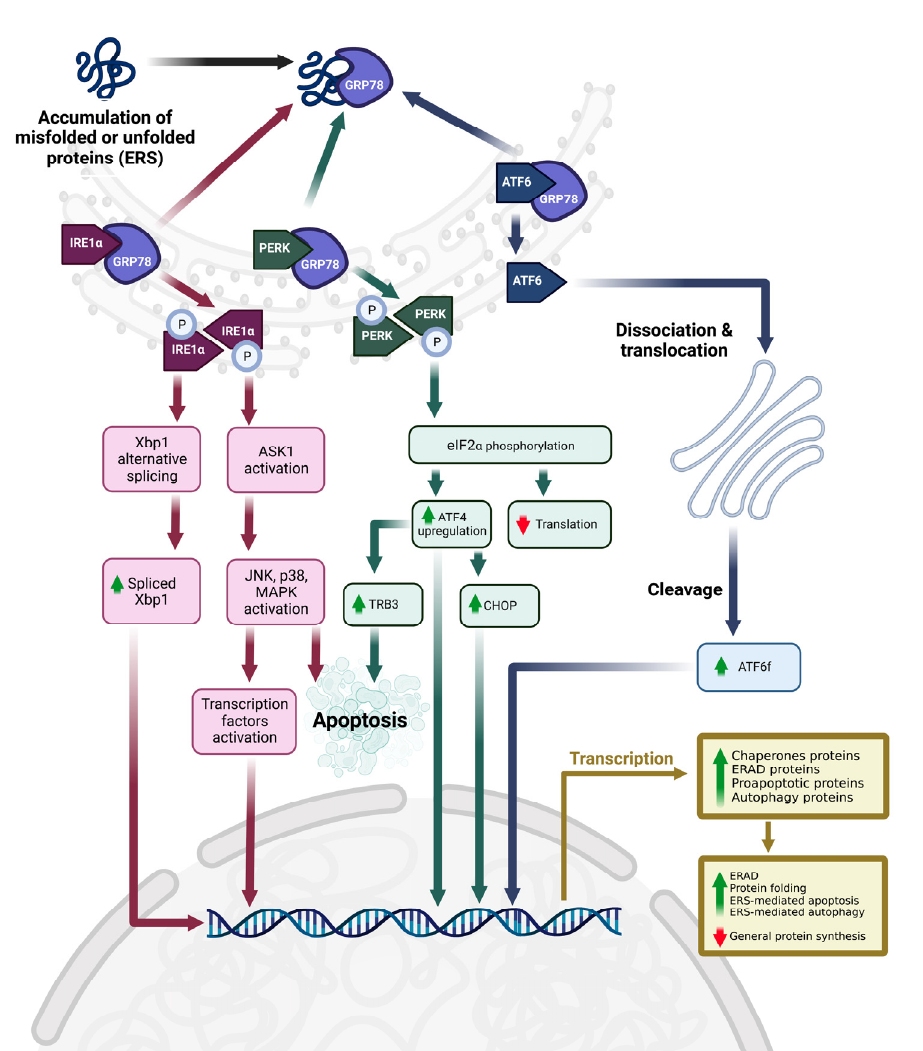
Figure 1. ERS, downstream UPR pathways, and cell fate. Abbreviations: ℗ , phosphorylated; ASK1, apoptosis signal-regulating kinase 1; ATF4, activating transcription factor 4; ATF6, activating transcription factor 6; ATF6f, ATF6 fragment or cleaved form; CHOP, CAAT/enhancer-binding protein homologous protein; eIF2 α , eukaryotic initiation factor 2 α subunit; ERAD, ER-associated degradation; ERS, endoplasmic reticulum stress; GRP78, 78 kDa glucose-regulated protein; IRE1 α , inositol requiring element 1 α ; JNK, c-Jun N-terminal kinase; MAPK, mitogen-activated protein kinase; PERK, protein kinase-like endoplasmic reticulum kinase; TRB3, tribbles 3; Xbp1, X-box binding protein 1. The figure was created by authors using BioRender.com on 4 April